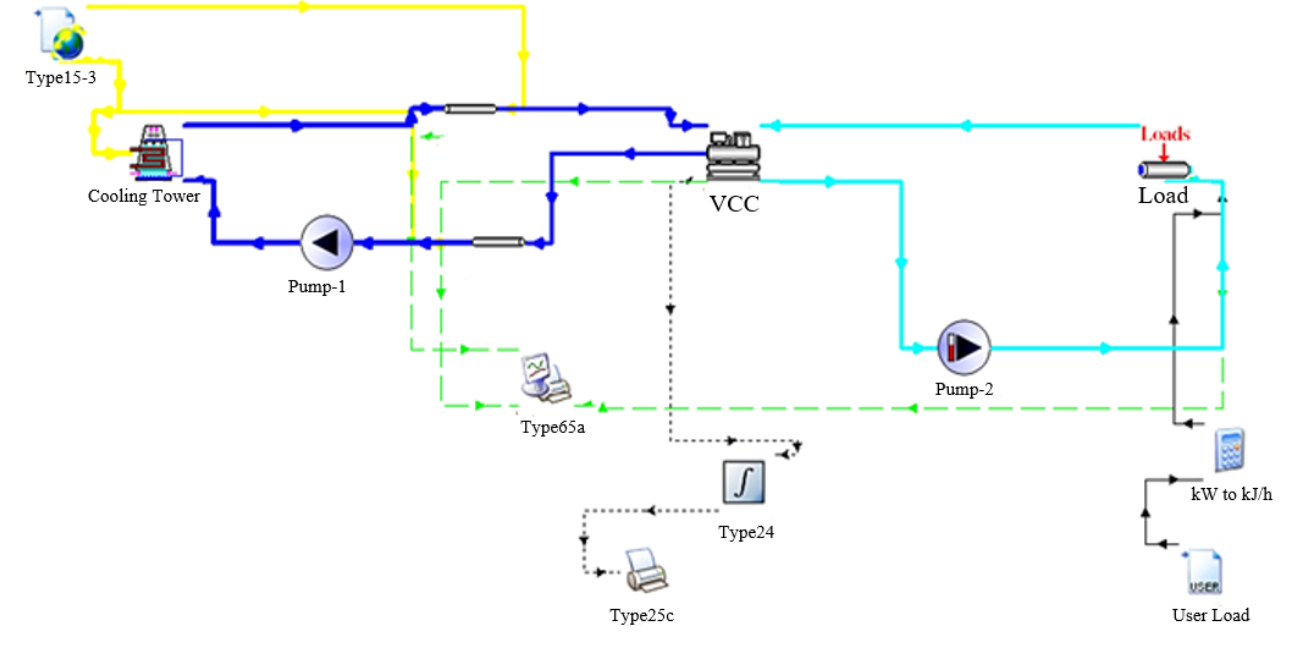
Figure 5. TRNSYS schematic of the proposed conventional vapour compression chiller for air conditioning showing the different parts of the